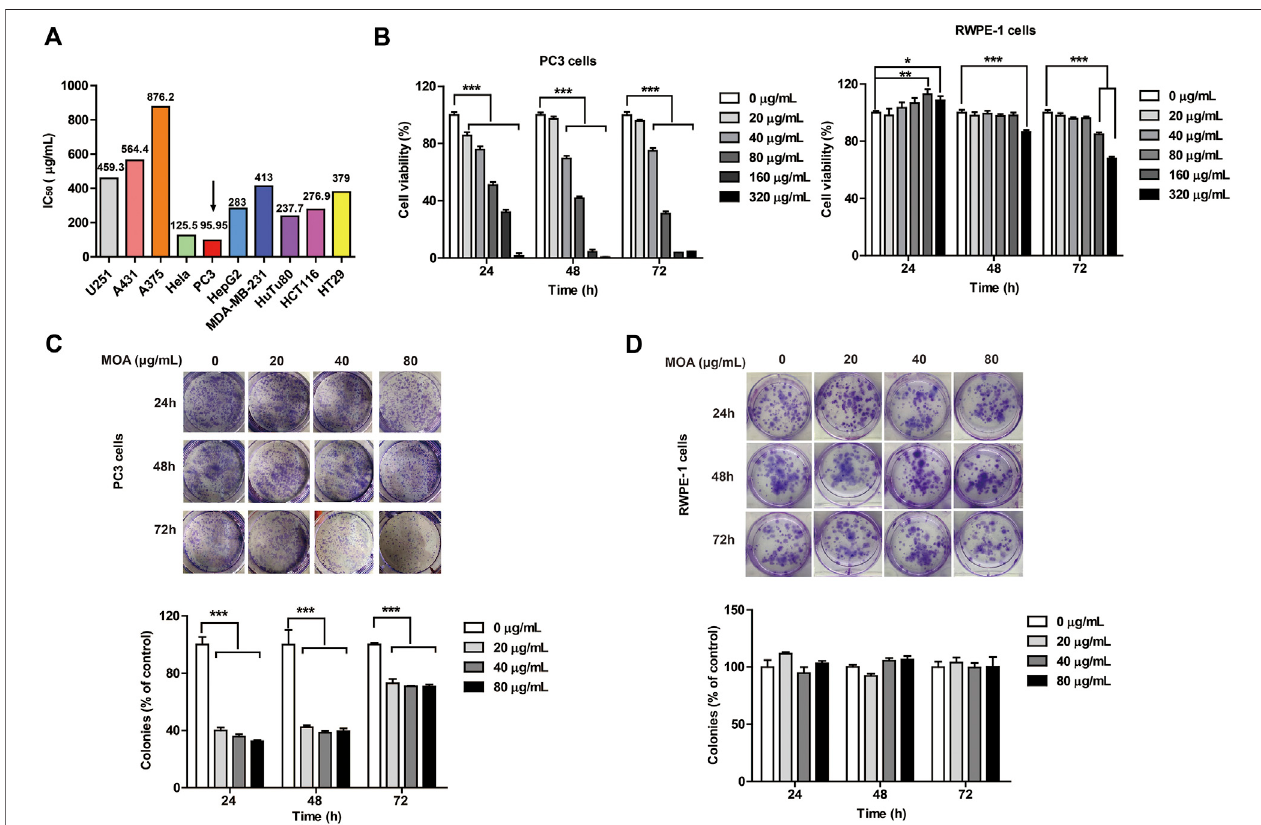
FIGURE 1 | The effect of MOA on the proliferation of PC3 and RWPE-1 cells. (A) The half maximal inhibitory concentration (IC 50 ) of ten tumor cell lines following treatment with MOA (0 – 320 μ g/ml) for 48 h. (B) Cell viability ofPC3 and RWPE-1 cells following MOA (0 – 320 μ g/ml) treatment for 24, 48, and 72 h (C,D) Analysis of the colony formation ability of PC3 and RWPE-1 cells following treatment with MOA (0, 20, 40, and 80 μ g/ml) for 24, 48, and 72 h. The cellular colony formation rates are expressed as fold changes. Results are expressed as the mean ± SEM of three independent experiments. * p < 0.05, ** p < 0.01, *** p < 0.001 vs. 0 μ g/ml.